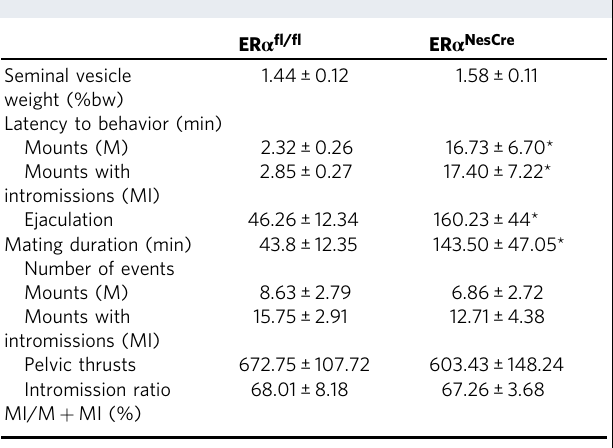
The mean weight±S.E.M of seminal vesicles is indicated as percentage of body weight (bw)for control (ER α fl / fl ) and mutant (ER α NesCre ) males, which were gonadectomized and normalized for their testosterone levels (9 – 10 males per genotype). The latencies and behavioral events are indicated for sexually experienced males that reached ejaculation (7 – 8 males per genotype). Data are means±S.E.M. * p <0.05 versus control